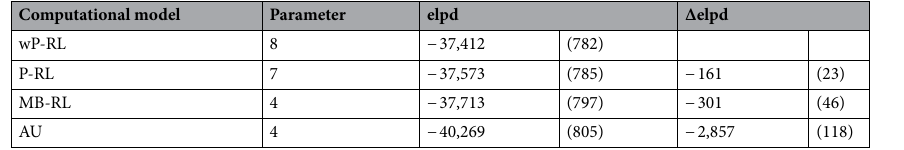
Table 2. Group-level results of Bayesian K -fold cross validation. Parameter number of free parameters, elpd estimated log predictive density, Δelpd difference in estimated log pointwise predictive density between a model and the best performing model; standard error in parentheses, AU attentional-updating model, MB- RL only model-based reinforcement-learning model, P-RL parallel reinforcement-learning model, wP-RL weighted parallel reinforcement-learning